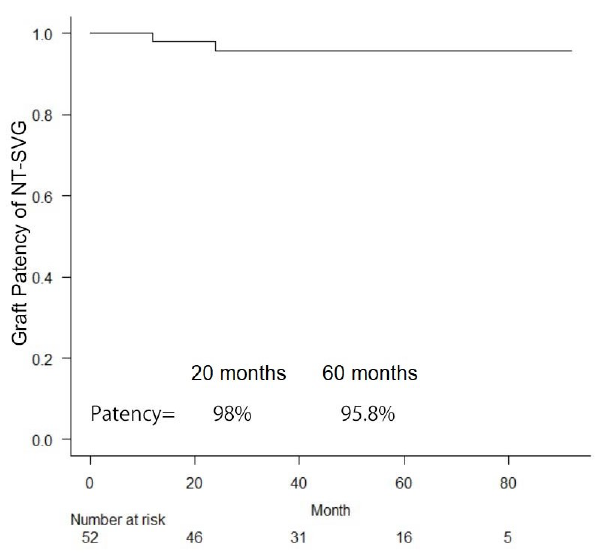
Fig. 3 - Midterm graft patency of “no-touch” saphenous vein grafts (NT-SVGs).